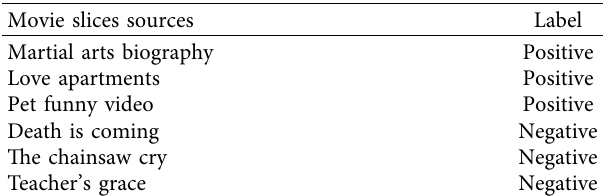
Table 1: The movie